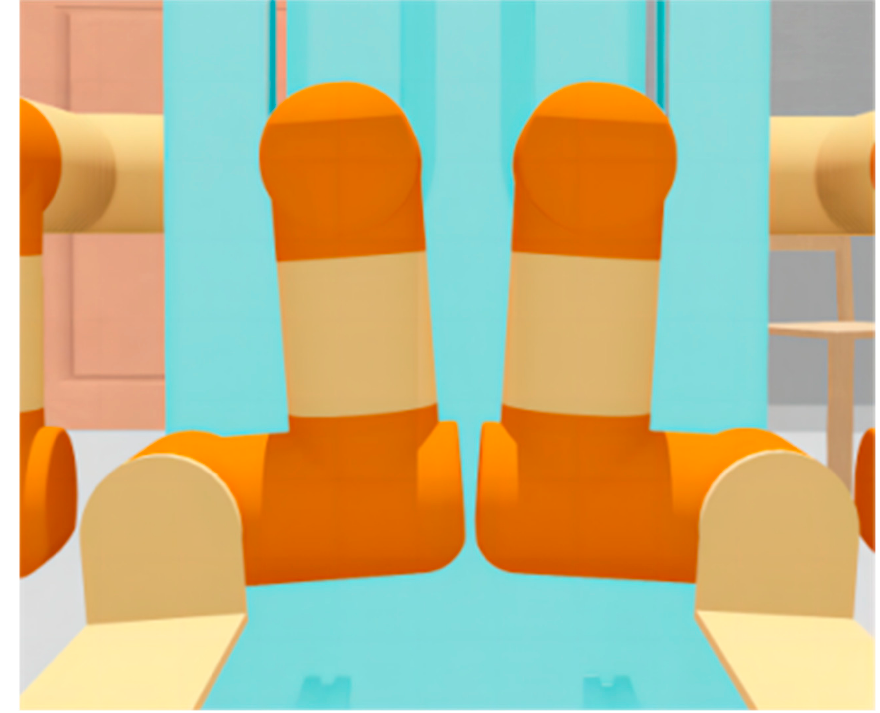
Figure 9. Dual-manipulator LF-RF with risk of self-collision.